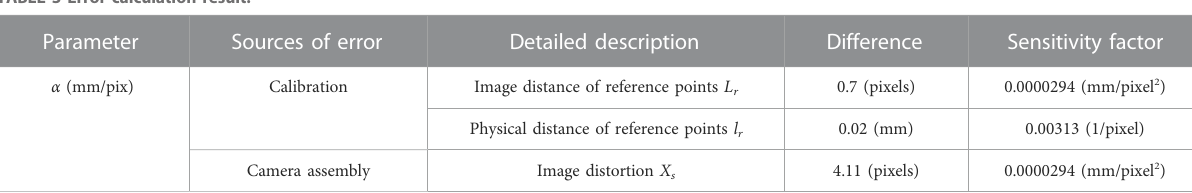
TABLE 3 Error calculation